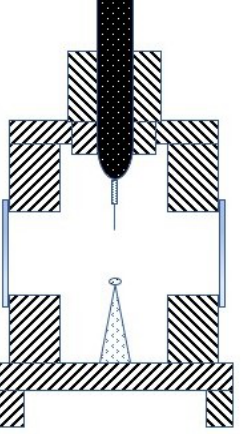
Figure 10. Lightning impulse tests electrodes configuration. Table 16. Maximal variations of the breakdown voltage and time to breakdown of nanofluids with respect to the base oils in lightning impulse tests.